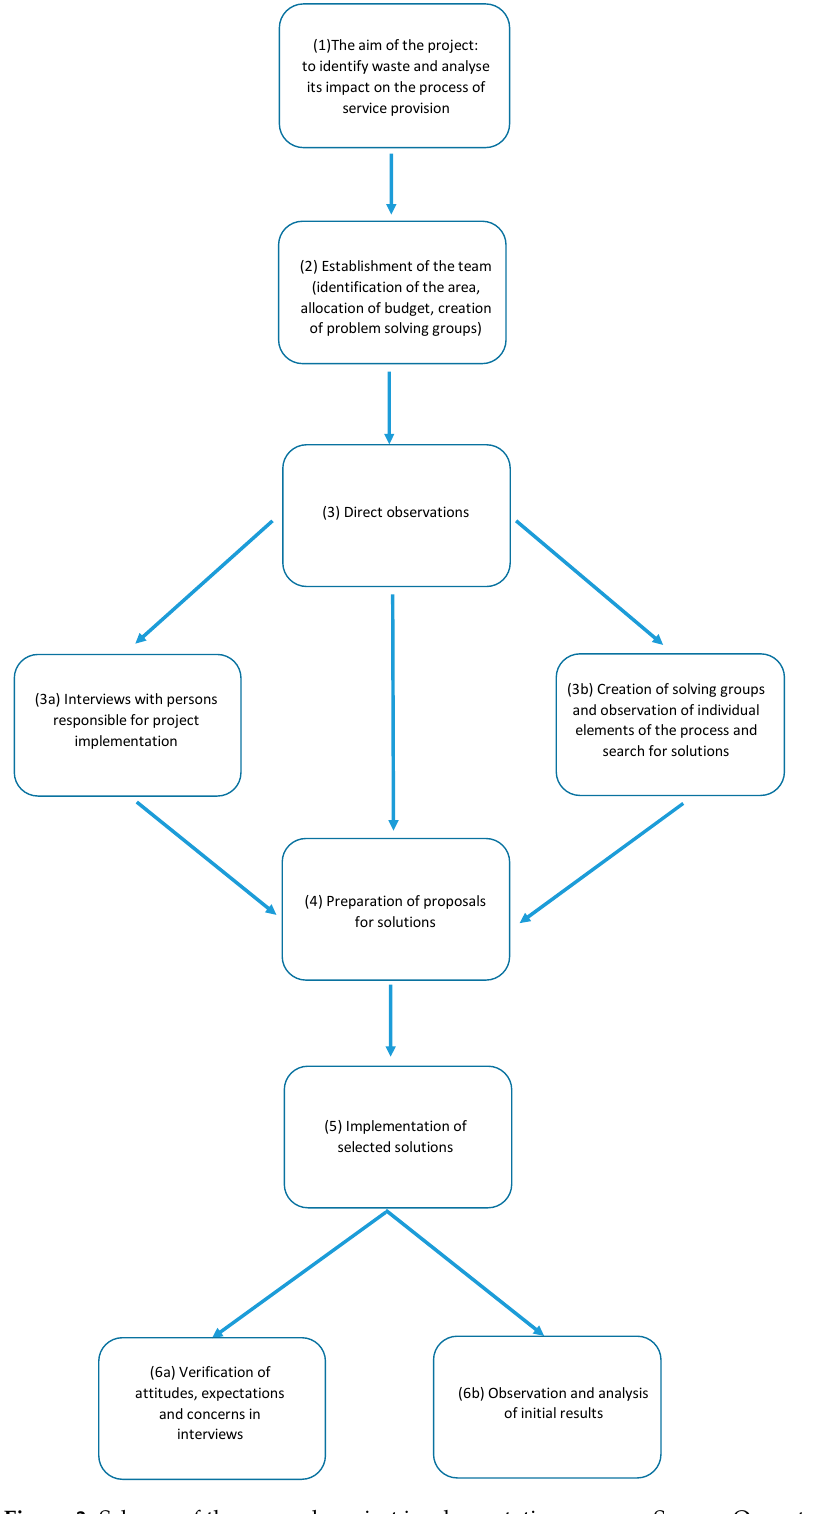
Figure 3. Scheme of the research project implementation process. Source: Own study.